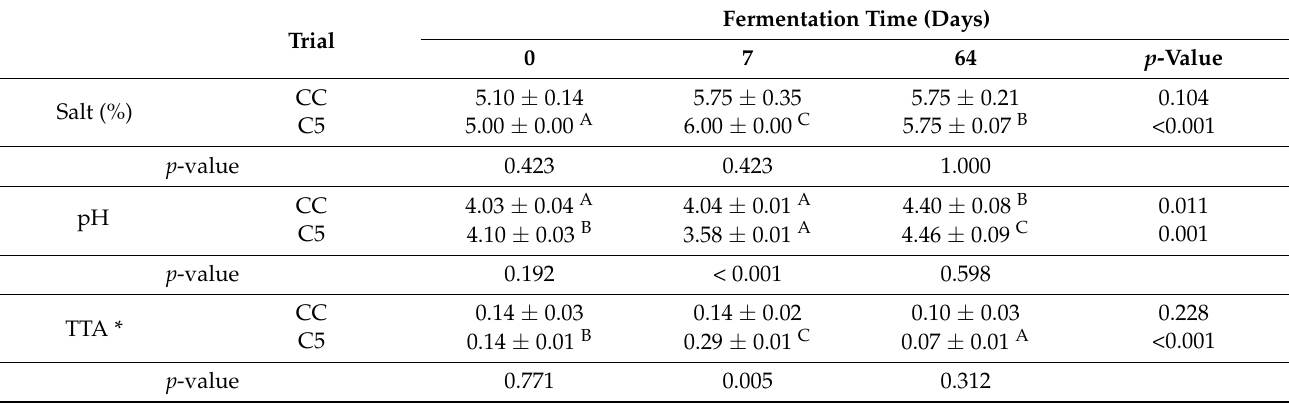
Table 3. Evolution in physicochemical features (salt content, pH, and total titratable acidity) of brine at selected times of fermentation under plan